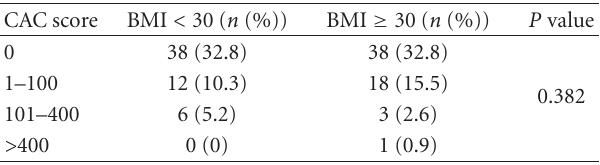
Table 5: Influence of obesity on total coronary artery calcium